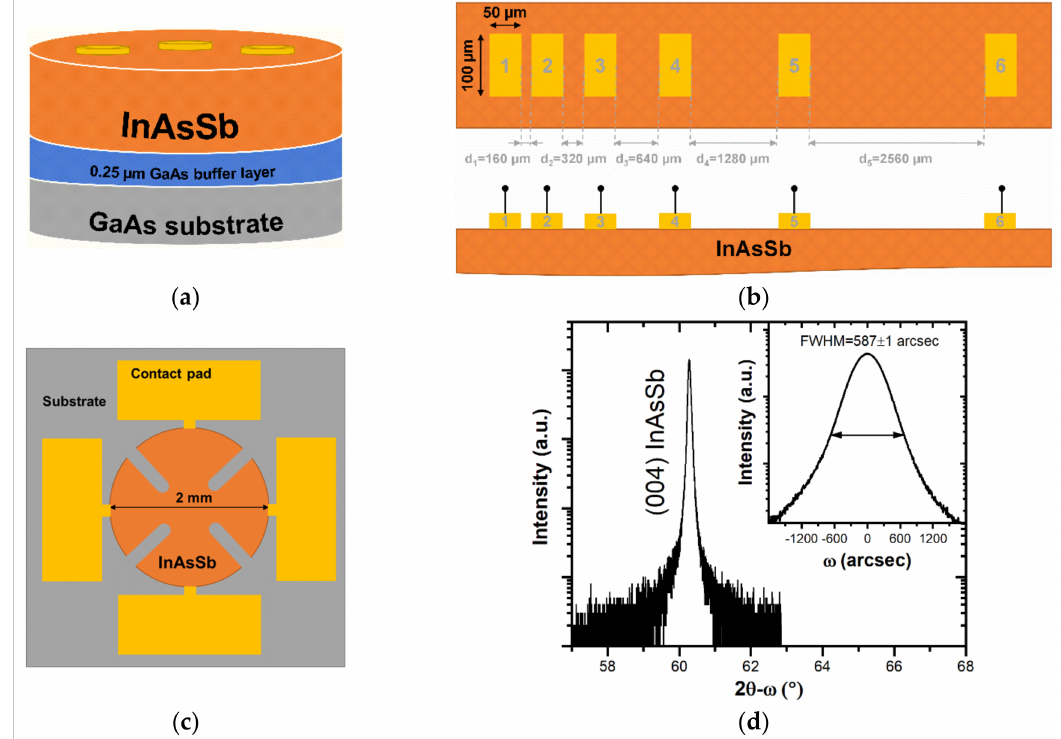
Figure 1. ( a ) Scheme presenting the architecture of the device structure under study. ( b ) Top-view and lateral (cross section) sketch of a linear TLM test structure with marked dimensions. ( c ) A cloverleaf van der Pauw geometry scheme with marked measurement area, contact pads and substrate. ( d ) (004) X-ray scans in ω -2 θ and ω directions of